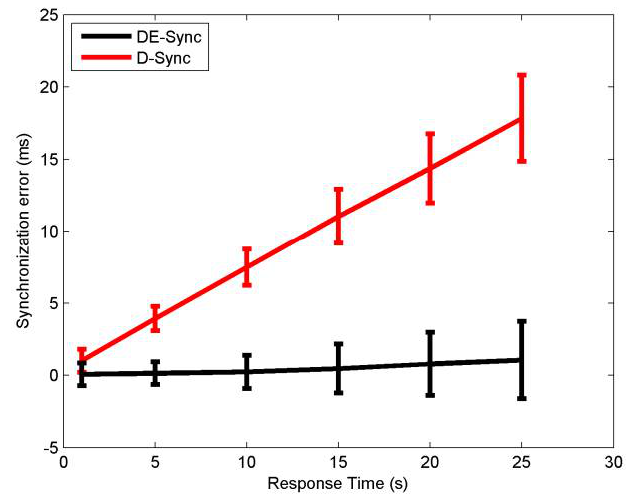
Figure 4. Performance with response time.